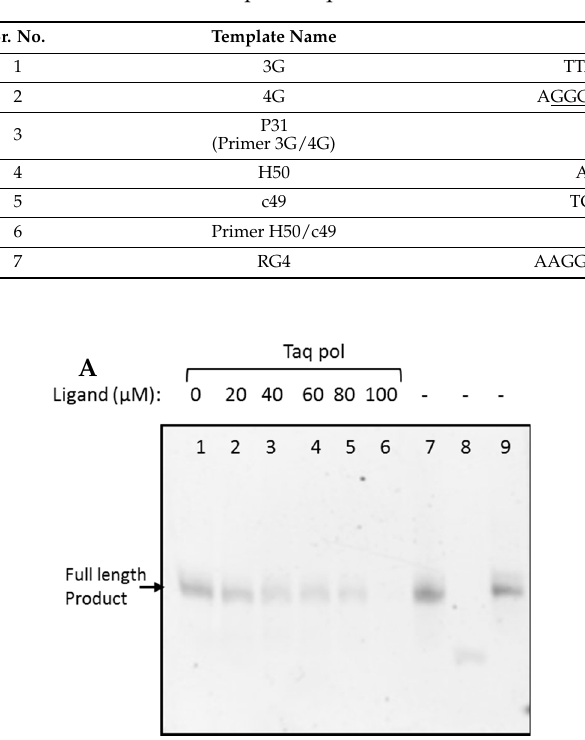
Figure 2. ( A ) Taq polymerase stop assay of 4G DNA sequence analyzed using 15% denaturing PAGE in presence of 0 to 100 µM of ligand B6,5. (Lane: 1–6) The ligand concentration and polymerase addition is as indicated in the gel image. The band in lane 7 represents template-primer in buffer without polymerase and ligand as a control. The bands in lanes 8 and 9 represent primer and template respectively. The incubation time for Taq polymerase was 1 h at 40 °C. ( B ) On the right hand side is the graphical representation of band intensity (lane 1–6) analyzed using ImageJ software. The error bar indicates the group error obtained on analyzing three consecutive gels having same sample set.